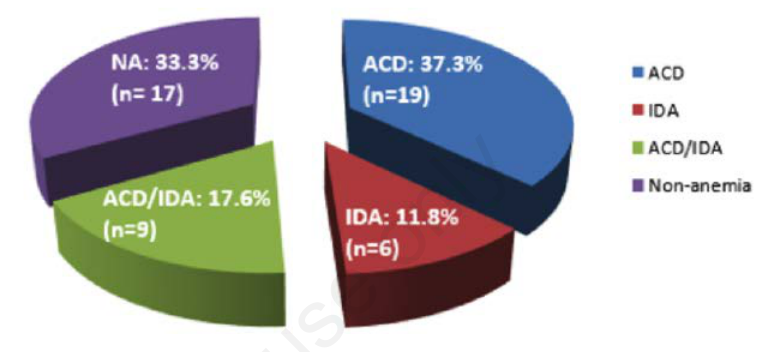
Figure 1. Anemia profile in 51 Rheumatoid arthritis